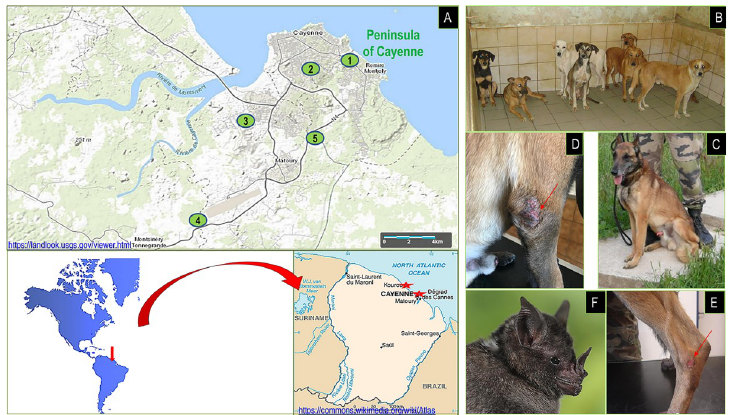
Fig 1. Study area and animal locations. A. Locations of L . infantum -infected animals, circles 1, 2 and 3: tree autochthonous dogs, circle 4: 4 MWD, circle 5: Bat ( copyright map: https://commons.wikimedia.org/wiki/Atlas_of_ French_Guiana; https://landlook.usgs.gov/viewer.html ; B.C. French Guiana autochtonus dogs and MWD (copyright pictures: B. Davoust). D.E. L . infantum skin lesions on MWD2 and MWD1 (copyright pictures: F Dulieu, L